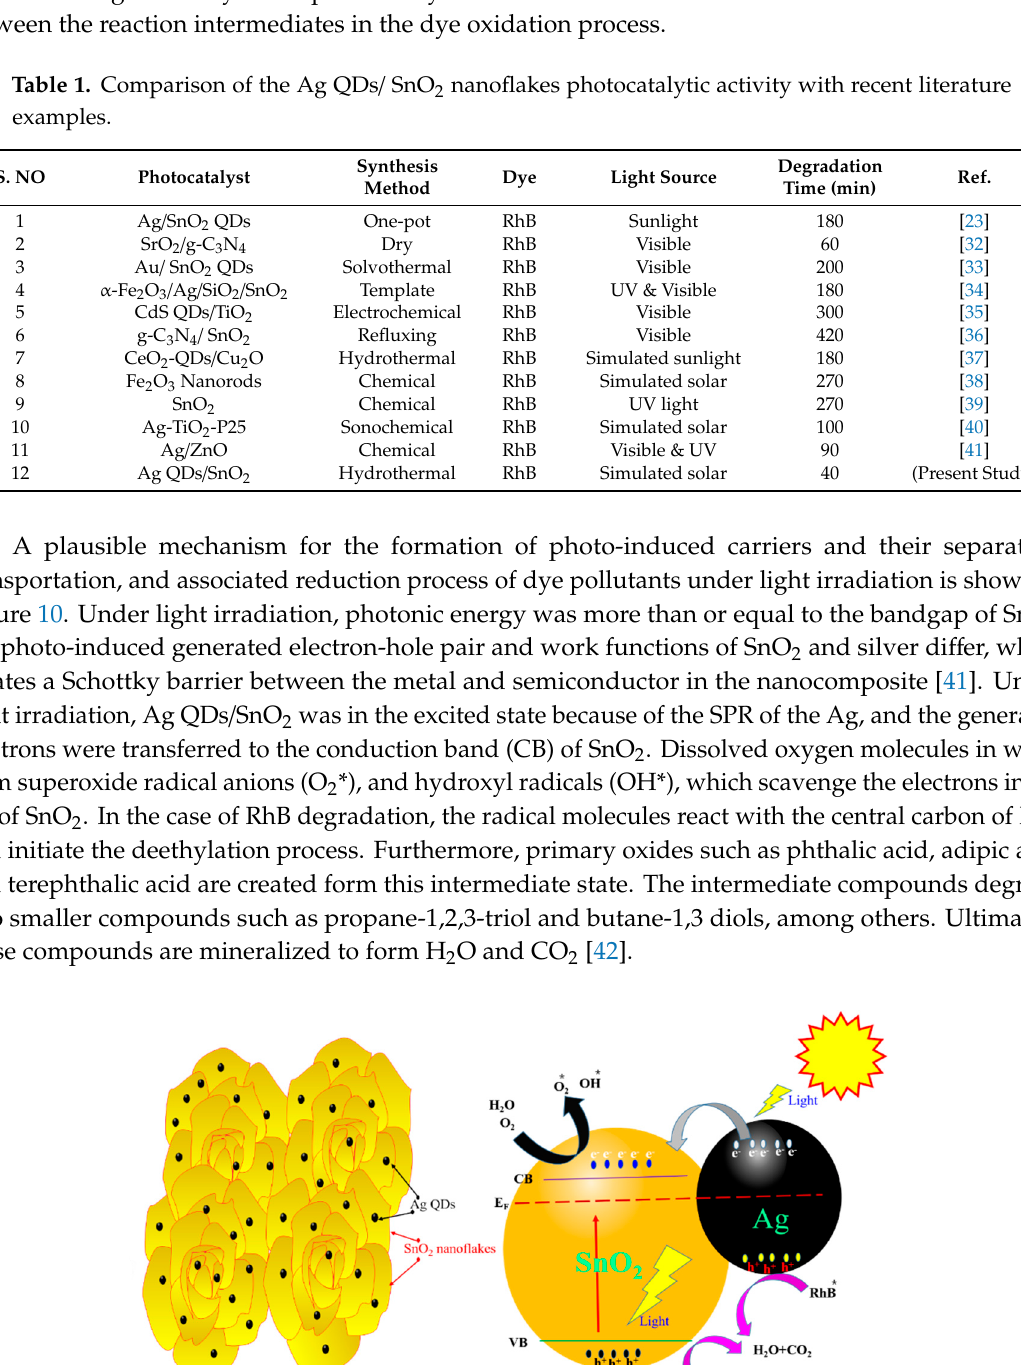
Table 1. Comparison of the Ag QDs/ SnO 2 nanoflakes photocatalytic activity with recent literature examples.